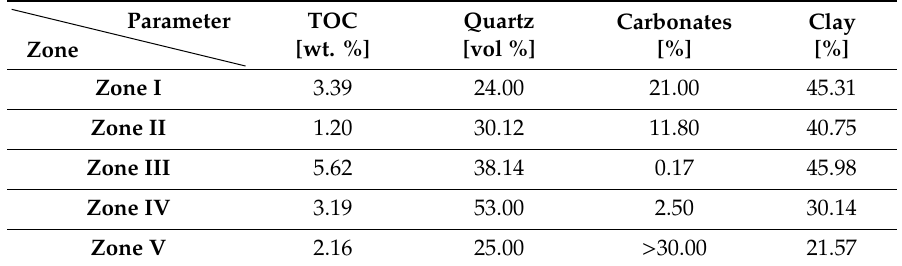
Table 1. Mineralogical characterization of distinguished zones of interest within Source I and Source II shale